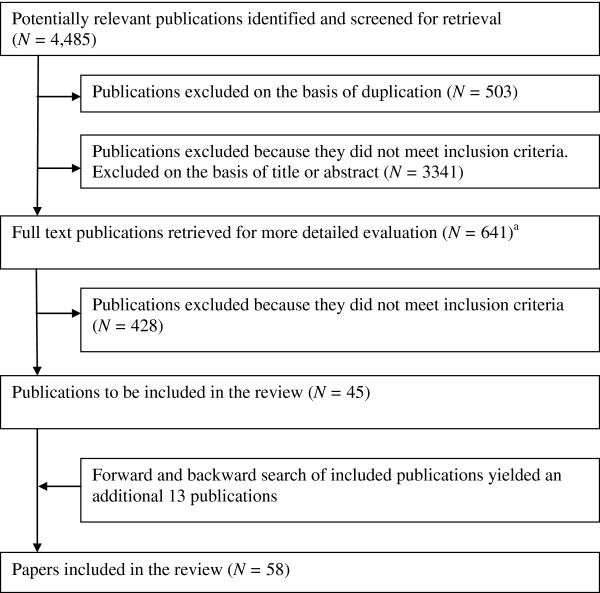
Flowchart describing the number of articles retrieved, and included and excluded at each stage of the review process. aThis number includes studies that were retrieved with another search criteria in mind see [17].1